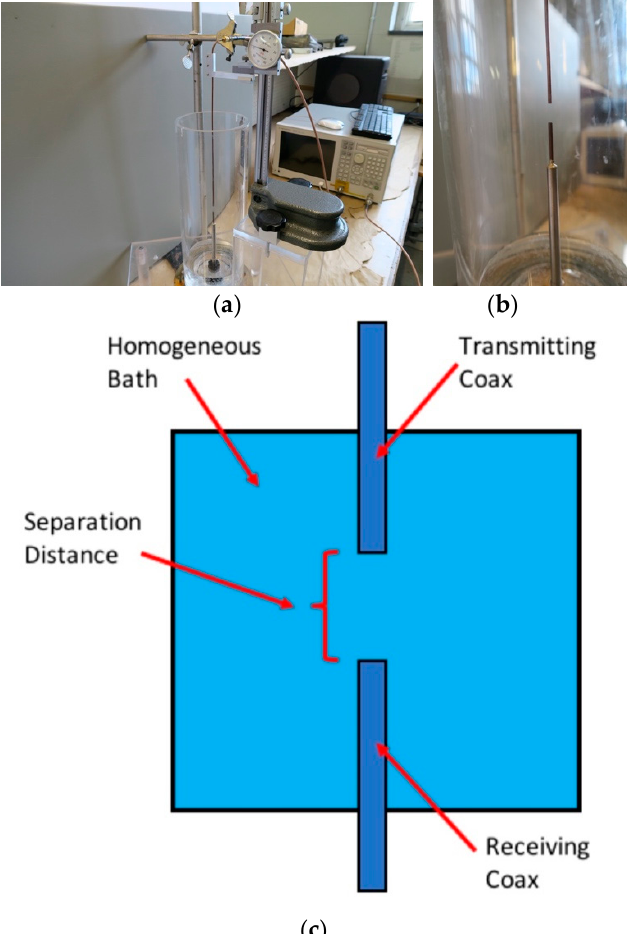
Figure 1. Photographs ( a , b ) and a schematic diagram ( c ) of the experimental set-up where the separation distances are accurately positioned through controlled motion of the calliper.